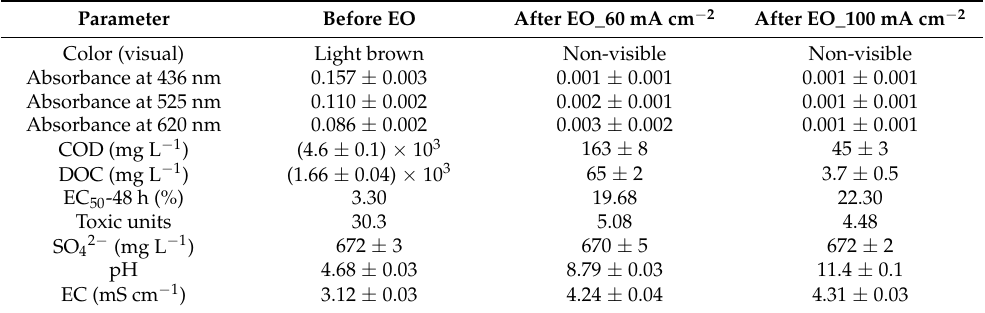
Table 2. Characterization of the TDW obtained from the primary dyeing process, before and after treatment by EO at 60 and 100 mA cm − 2